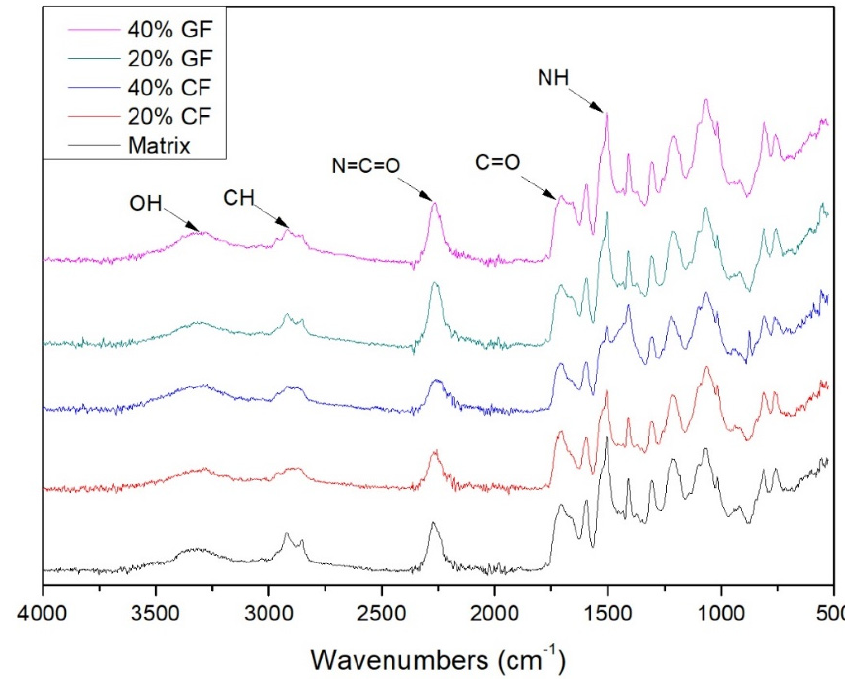
Figure 6. FTIR (Fourier transform infrared spectroscopy) spectra of the matrix. It can be observed that the spectra for matrix and glass/carbon fiber filled polyurethanes are very similar. For better visualization, only the matrix spectra will be described. A broad peak from around 3300 to 3400 cm − 1 comes from OH stretching vibrations. Peaks around 2900 and 2800 cm − 1 are from aliphatic CH 2 symmetric and asymmetric stretching vibrations, respectively [30]. Stretching vibrations of carbonyl groups from urethane bond or carbonyl compounds from cellulose decomposition during the liquefaction process are present at around 1700 cm − 1 [31]. From the received spectra, it can be concluded that the final product contained a significant amount of isocyanate groups, which is confirmed by the sharp and strong peak of the stretching vibrations of the isocyanate group at around 2250 cm − 1 . It can be related to the presence of NCO groups at the chain ends or with the presence of unreacted isocyanate [30]. However, the difference between glass and carbon fiber filled composites can be observed in this peak intensity. It can be observed that for glass fiber filled composites, the NCO peak is almost identical to the corresponding peak from the matrix. For carbon fiber filled composites, the NCO peak intensity decreases with the increasing amount of CF in the sample. It may be related to a much higher heat conductivity of carbon fibers compared to glass fibers and the matrix. All samples were thermally cured before the measurements. The higher heat conductivity of carbon fiber filled samples provided better heat distribution in the polymer matrix and improved the reaction speed of unreacted NCO groups [33]. The band at around 1500 cm − 1 corresponds to the NH bending vibrations of the urethane